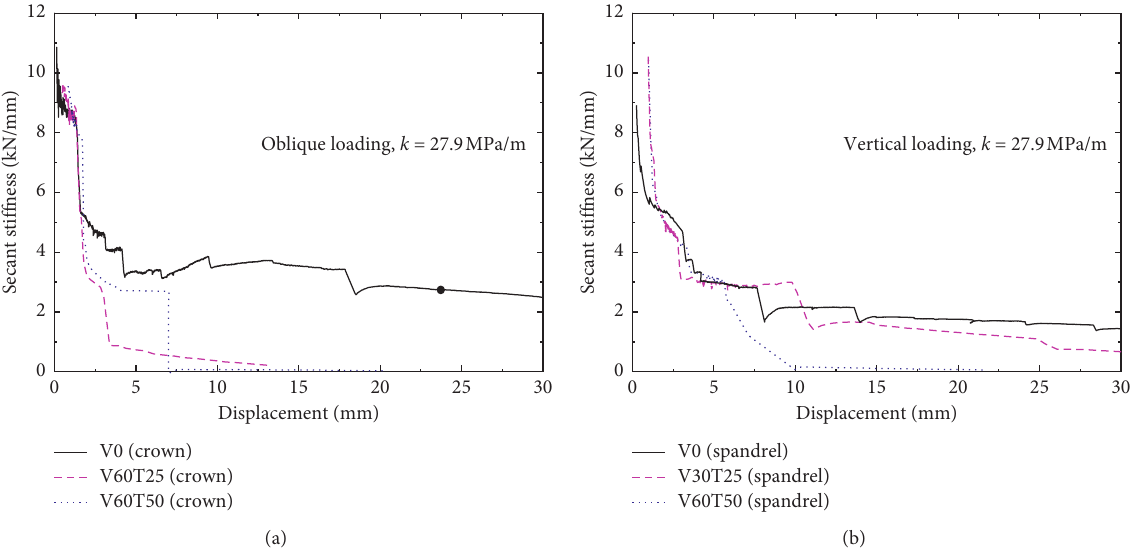
Figure 16: Secant stiffness-displacement curve of the lining with combined defects: (a) crown and (b) spandrel.